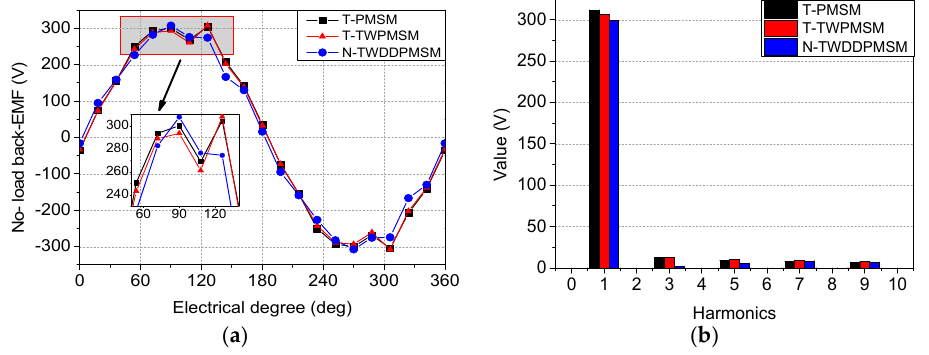
Figure 10. Back-EMF waveforms of three motors under no load: ( a ) back-EMF waveforms; ( b ) harmonics of back-EMF.